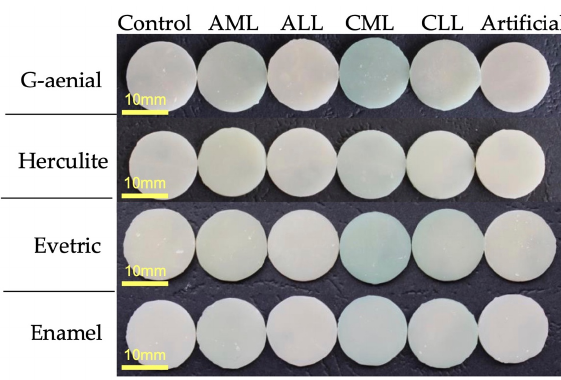
Figure 4. Color stability for dental composite.